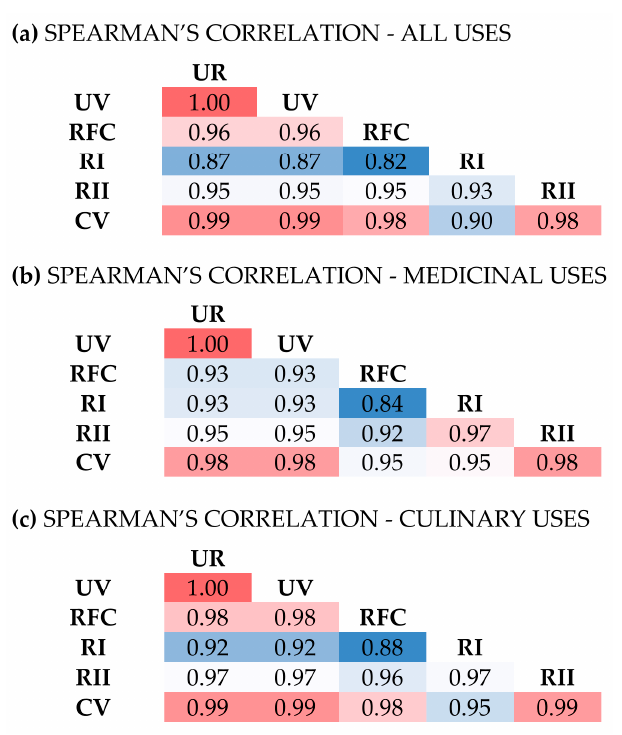
Figure 5. Spearman’s correlation matrices indicating the correlations among the number of use reports (UR), the use value (UV), the relative frequency of citation (RFC), the relative importance (RI), the relative importance index (RII), and the cultural value index (CV) for all uses ( a ), medicinal uses ( b ), and culinary uses ( c ). Spearman’s coefficient, the value in each cell for each combination of variables, is a measure of the strength and direction (negative or positive) of the association between the two indices and ranges from 0 (negligible association) to 1 (very high association). The lowest values per matrix are noted with dark blue color while the highest with dark red color, low and high values are noted using lighter blue and red colors, respectively, while intermediate values are white.